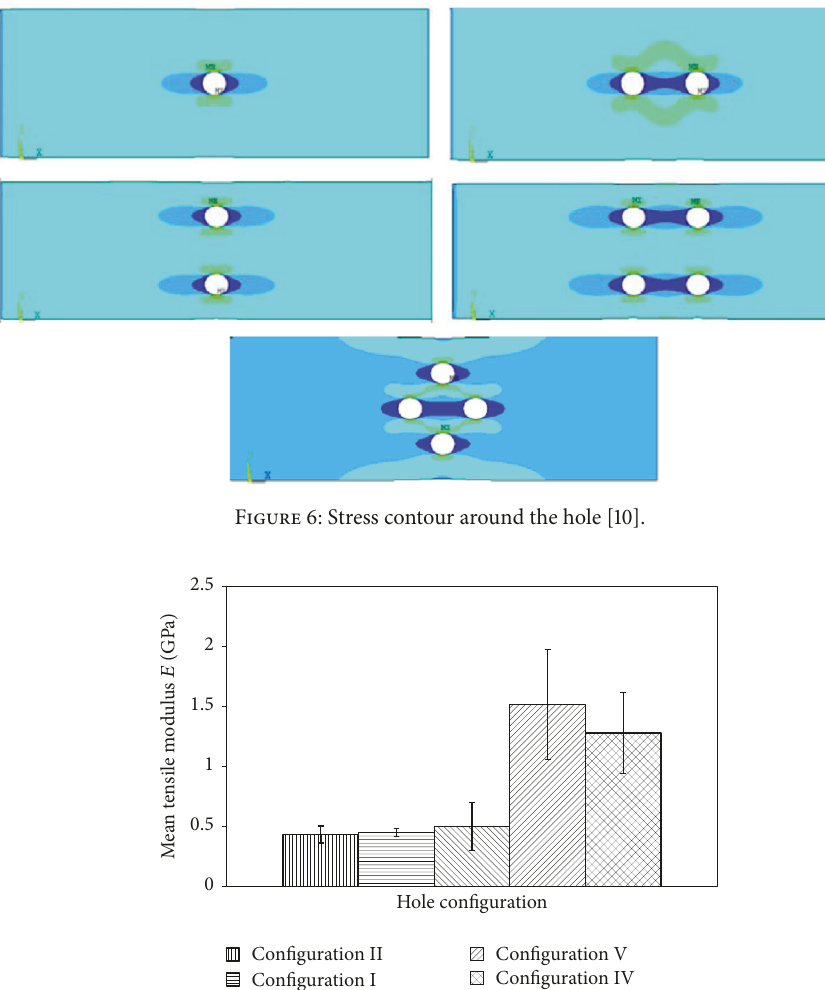
stress areas. These different conditions of stress-strain for different hole configuration ultimately have an effect on tensile modulus